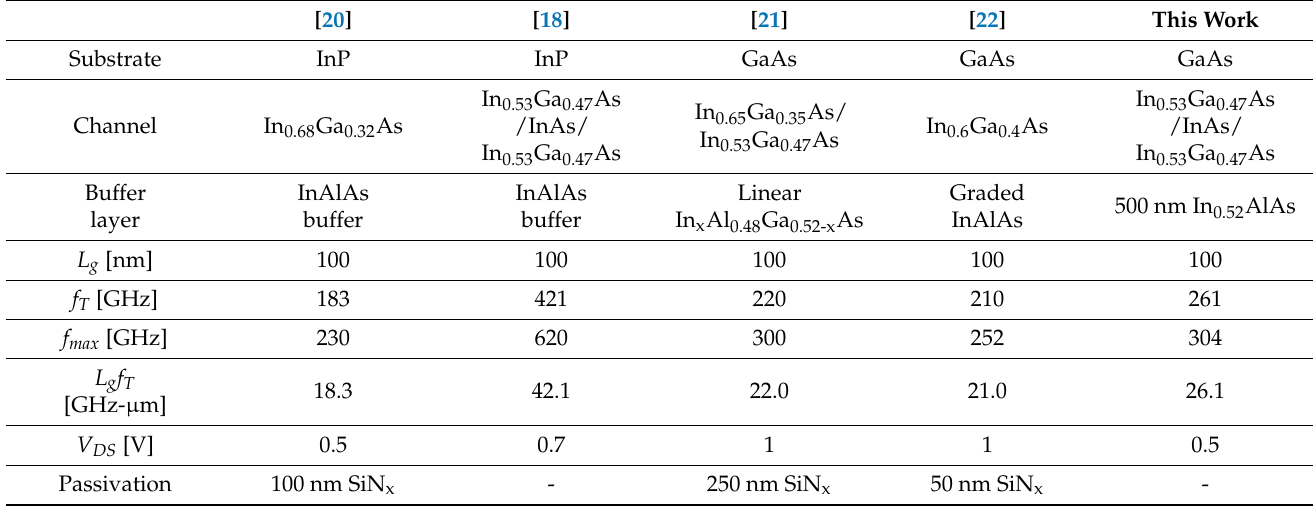
Table 2. Performance parameters of the pHEMTs and mHEMTs with a L g of 100